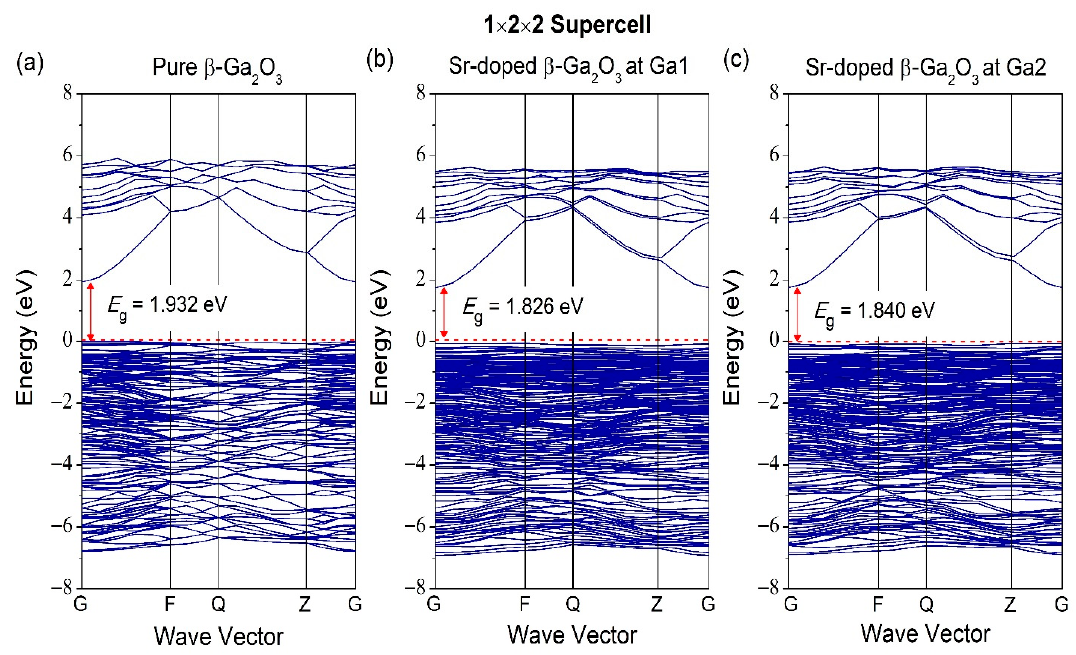
Figure 7. Band structure of ( a ) pure β -Ga 2 O 3 , ( b ) Sr-doped β -Ga 2 O 3 at Ga1, and ( c ) Sr-doped β -Ga 2 O 3 at Ga2 without scissor operator.